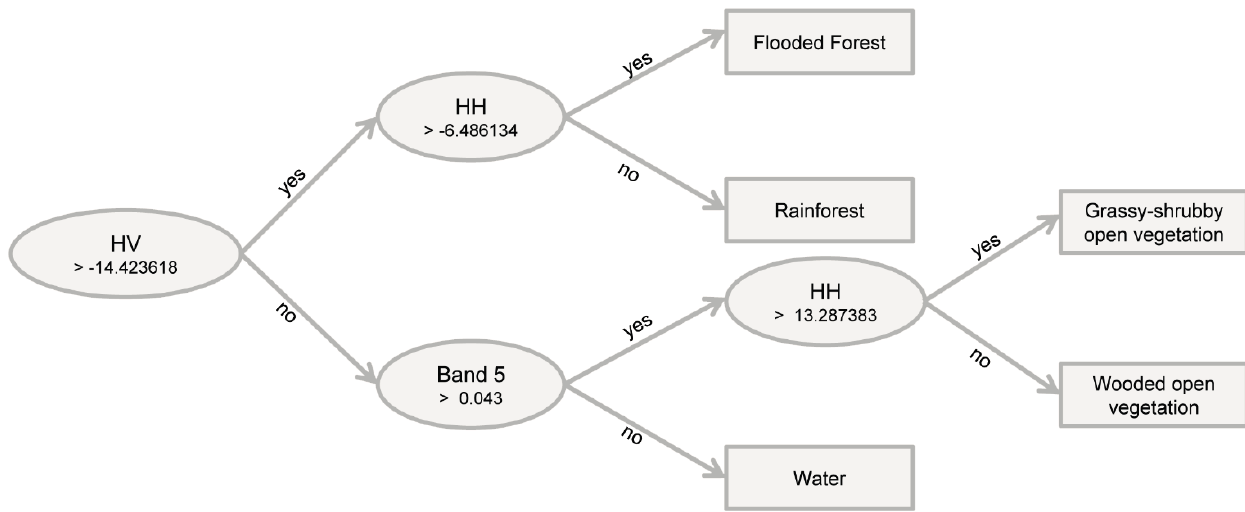
Figure 5. Decision tree for the study area obtained with the C4.5 algorithm using TM/Landsat and PALSAR